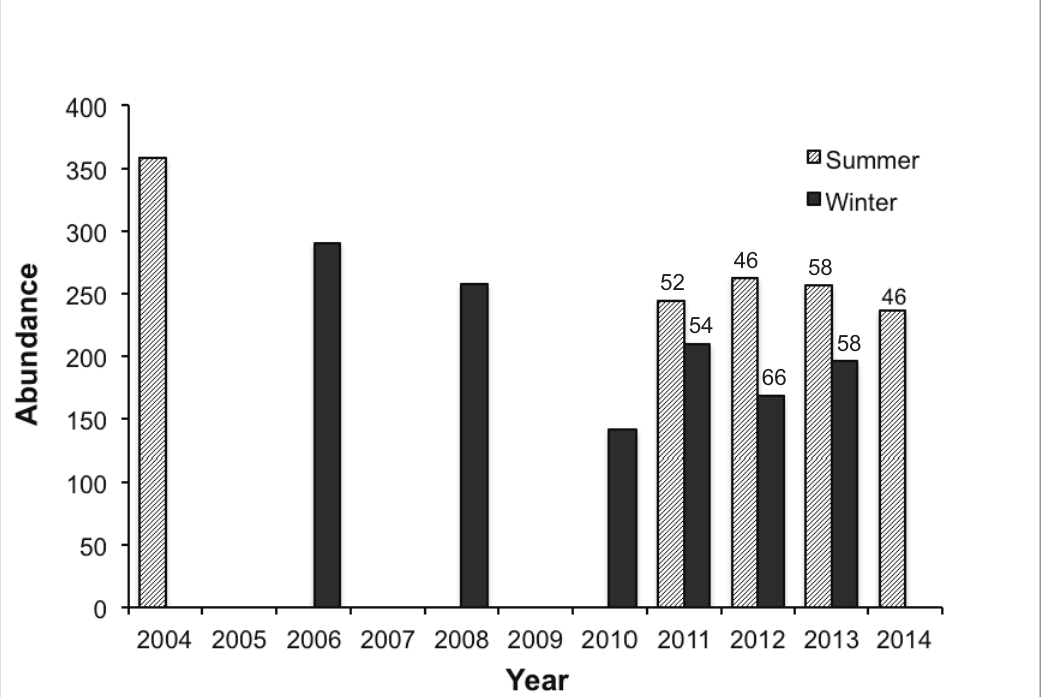
Figure 3. Abundance of Eastern Grey Kangaroos Macropus giganteus at Anglesea